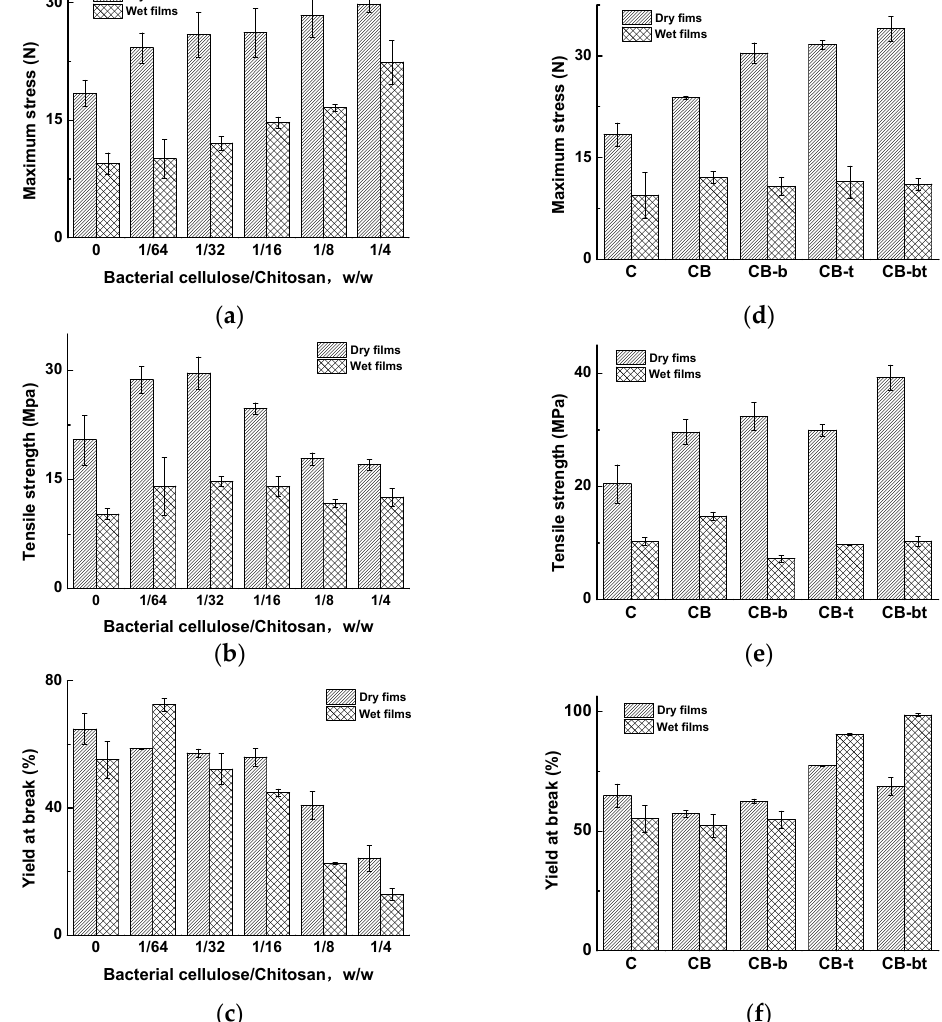
Figure 1. The impact of cross-linking treatment on the maximum strength, tensile strength, and yield at the break of dry and wet films of various ratios of bacterial cellulose/chitosan, chitosan (C), and 1/32 bacterial cellulose/chitosan (CB) treated with 4% borate (CB-b), 4% tripolyphosphate (CB-t), or a mixture of 2% borate and 2% tripolyphosphate (CB-bt). ( a ) maximum strength of Bacterial cellulose/Chitosan composite with varying weight ratio; ( b ) tensile strength of Bacterial cellulose/Chitosan composite with varying weight ratio; ( c ) yield at the break of Bacterial cellulose/Chitosan composite with varying weight ratio; ( d ) maximum strength 1/32 Bacterial cellulose/Chitosan composite with varying mode of cross linking; ( e ) tensile strength of 1/32 Bacterial cellulose/Chitosan composite with varying mode of cross linking; ( f ) yield at the break of 1/32 Bacterial cellulose/Chitosan composite with varying mode of cross linking.